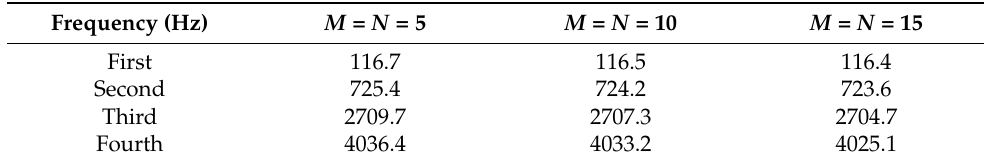
Table 4. Frequencies with different mode numbers.